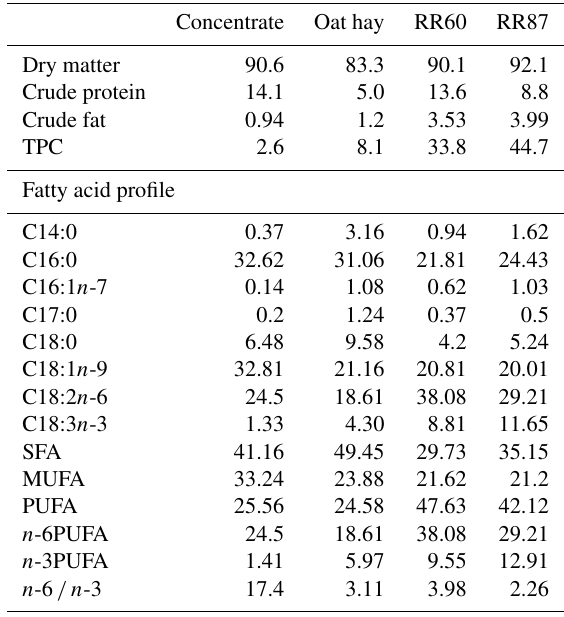
Table 1. Chemical compositions (% dry matter) and fatty acid pro- files as % FAMEs (mg FAME per 100mg FAMEs) of experimental